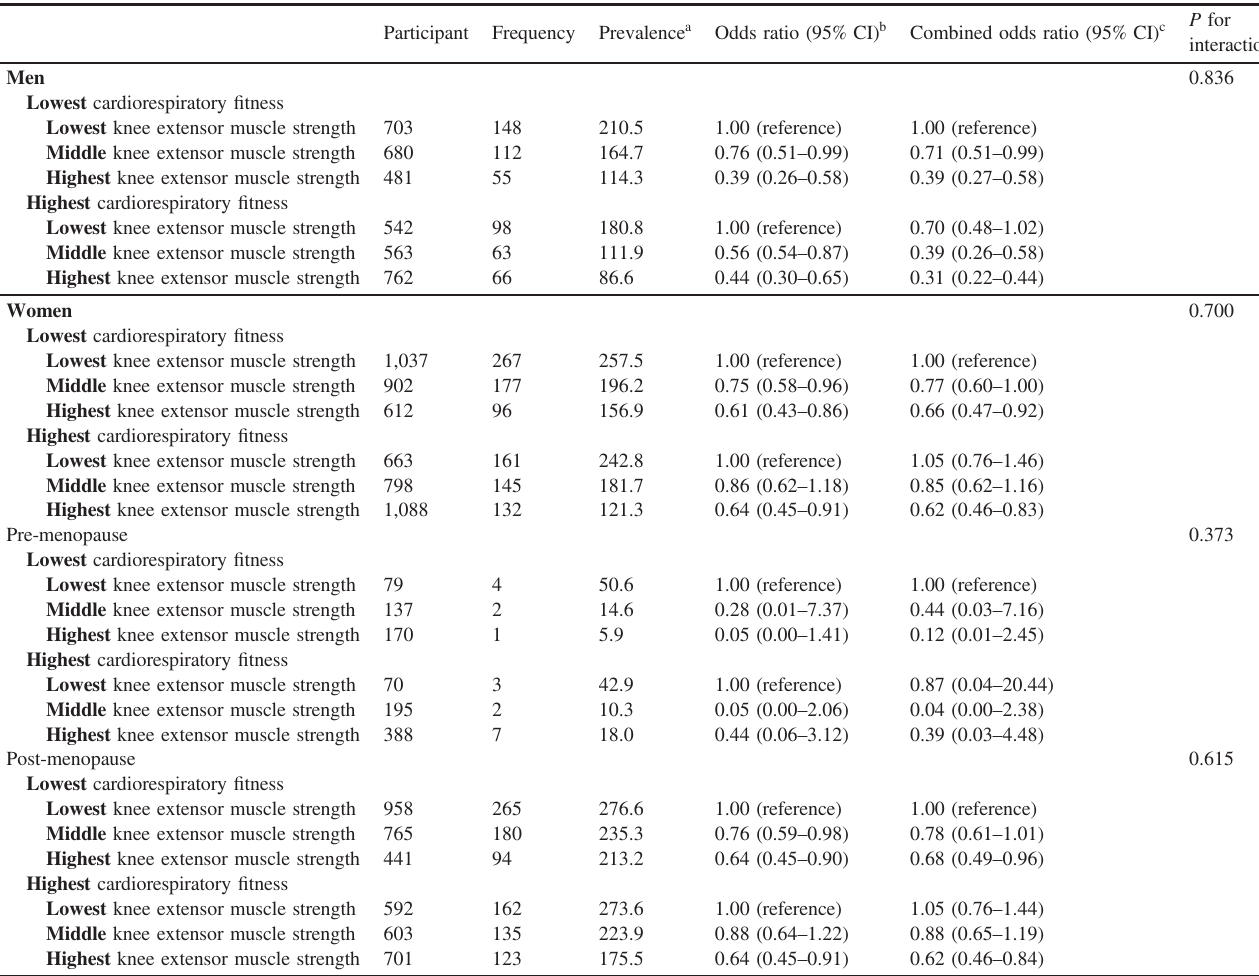
Table 4. Interacting association of knee extensor muscle strength and cardiorespiratory fi tness with low bone sti ff ness